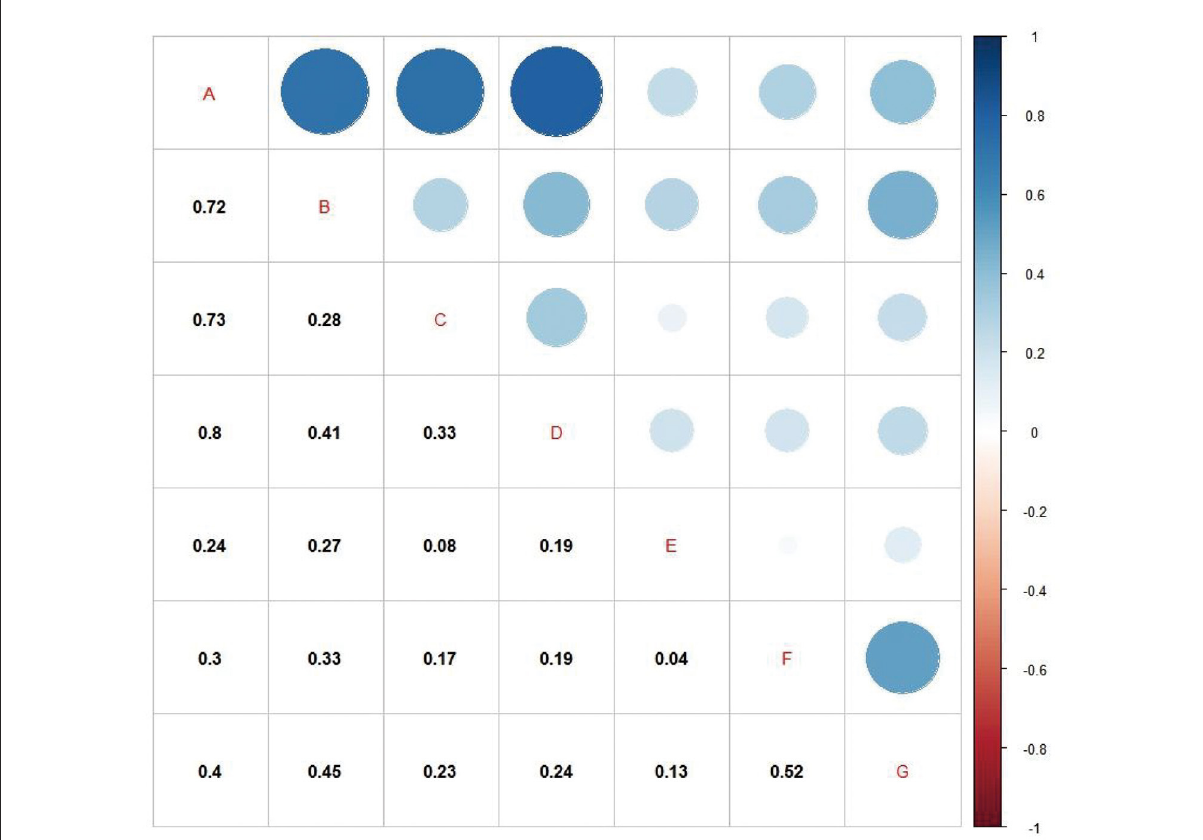
FIGURE2 Correlation analysis of factors affecting sleep health. (A) Sleep health score; (B) Sleep duration score; (C) Sleep disturbance score; (D) Subjective sleep quality score; (E) Time for doing homework; (F) Screen time per day during school; (G) Frequency of using electronics 30min before bedtime. All of p < 0.001. The color shades and size of the circle indicate the correlation coefficient ( r ) between any two